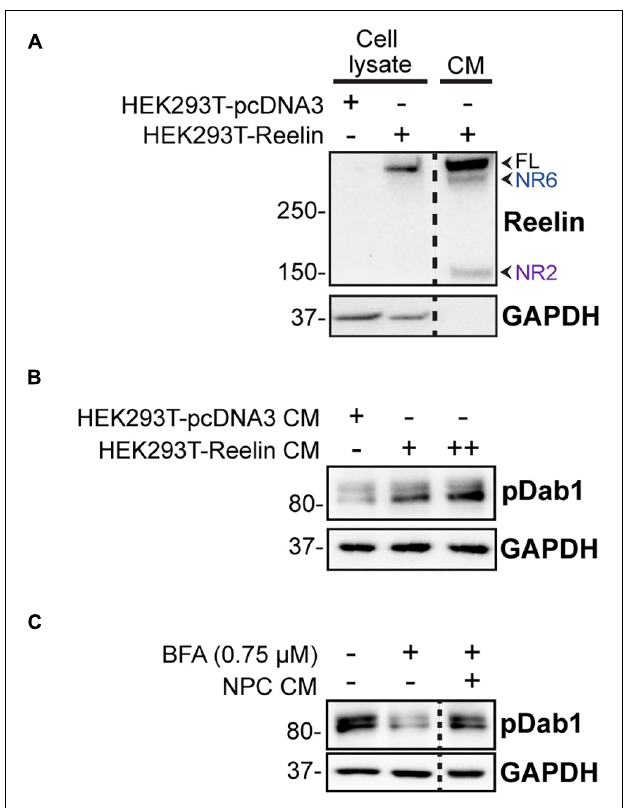
FIGURE 9 | Reelin induces Dab1 phosphorylation in NPCs. (A) Western blot of medium conditioned by HEK293T cells transfected with a Reelin-expressing plasmid or empty vector (pcDNA3) and their cell lysates indicates expression and secretion of Reelin. Lysates and conditioned medium (CM) were collected 24 h after transfection. Arrows indicate full-length (FL) Reelin and NR2 and NR6 fragments. (B) WT NPCs treated with 200 µ L (+) or 400 µ L (++) conditioned medium (CM) from Reelin-transfected HEK293T cells for 10 min have increased Dab1 phosphorylation (pDab1). (C) A total of 20 min treatment with CM from WT NPC cultures increases Dab1 phosphorylation in WT NPCs ( n = 4 separate cultures). Pretreatment with Brefeldin A (BFA; 0.75 µ g/mL) for 3 h prior to CM treatment reduces Dab1 phosphorylation in WT NPCs, indicating that the state of Dab1 phosphorylation depends on the ability of cells to secrete proteins. Addition of BFA to CM after harvesting does not affect pDab1 induction. Relative band density was normalized to GAPDH. Fold change was 2.19 with p = 0.023 by one-sample t -test.